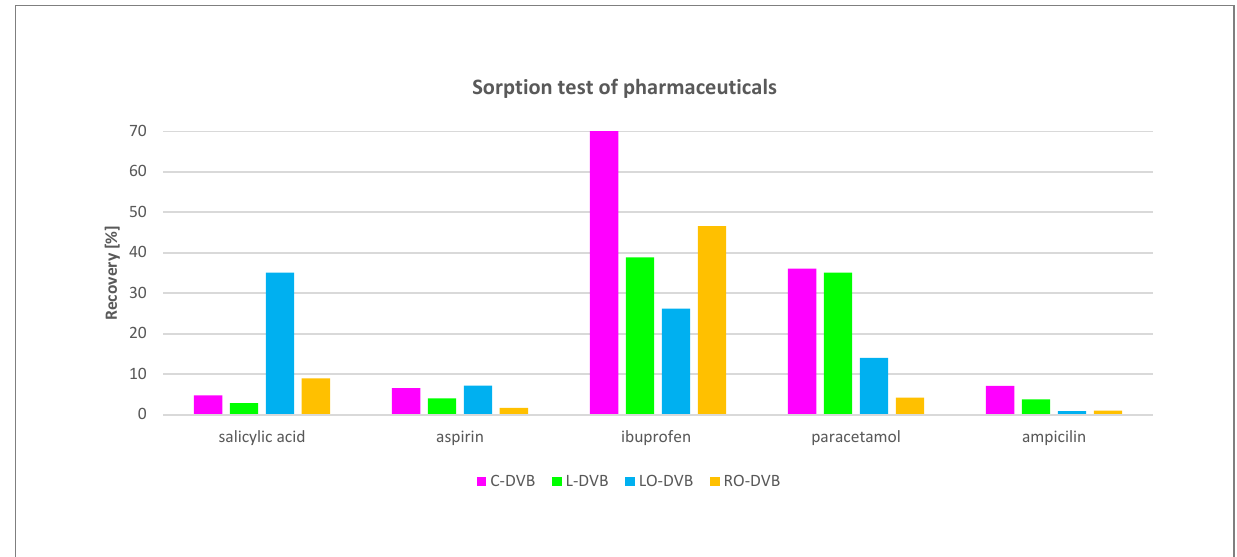
Figure 8. SPE results for C-DVB, L-DVB, Lo-DVB, and Ro-DVB.